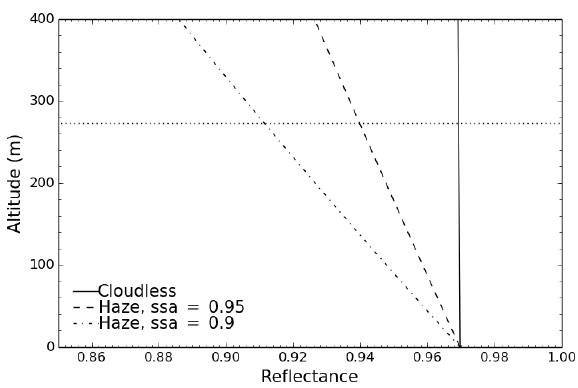
Figure 9. Simulated UAS reflectance for MODIS band 1 as a func- tion of flight altitude for various sky conditions. See text for details. The dotted horizontal line indicates the average flight altitude of the UAS on 5 August. The solar zenith angle is 58 ◦ , corresponding to the values during the flight on 5 August (see Table